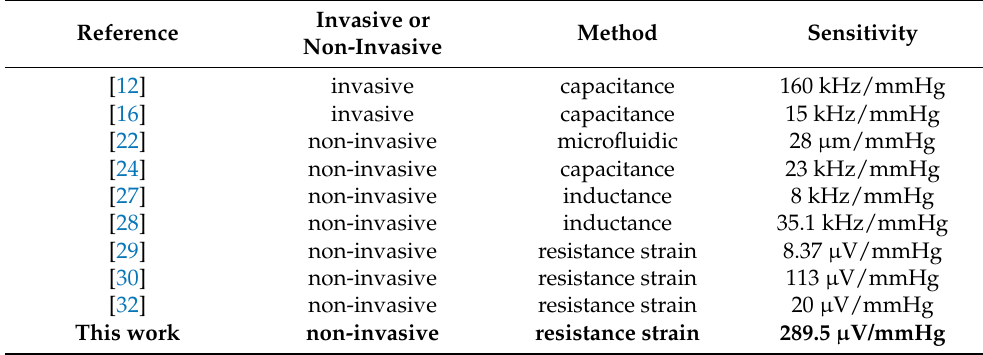
Figure 5. The response of the sensor’s output voltage to variations in silicone eyeball pressure. Table 2. Performance comparison with previous reports.